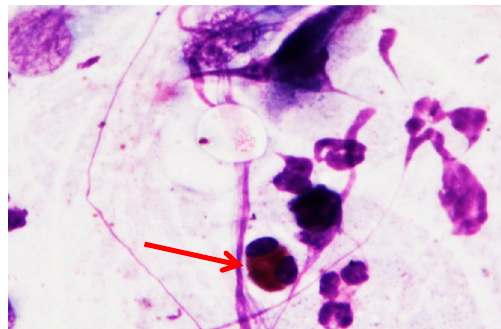
Figure 3. Optical microscope image. The red arrow shows the presence of eosinophils (100 × image enlargement, oil immersion). In cases of allergic rhinitis, eosinophils are pathognomonic elements.